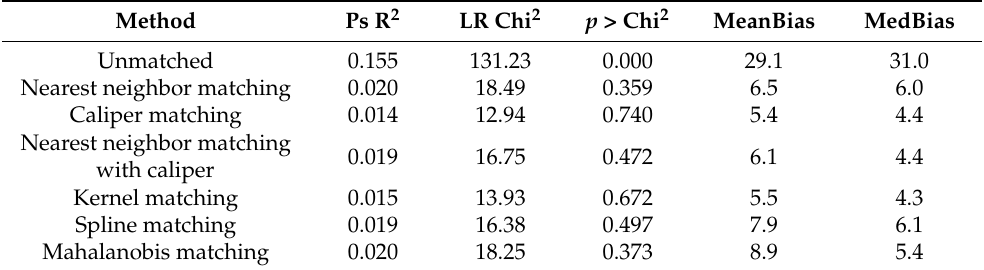
Table 2. Test for overall matching quality by matching